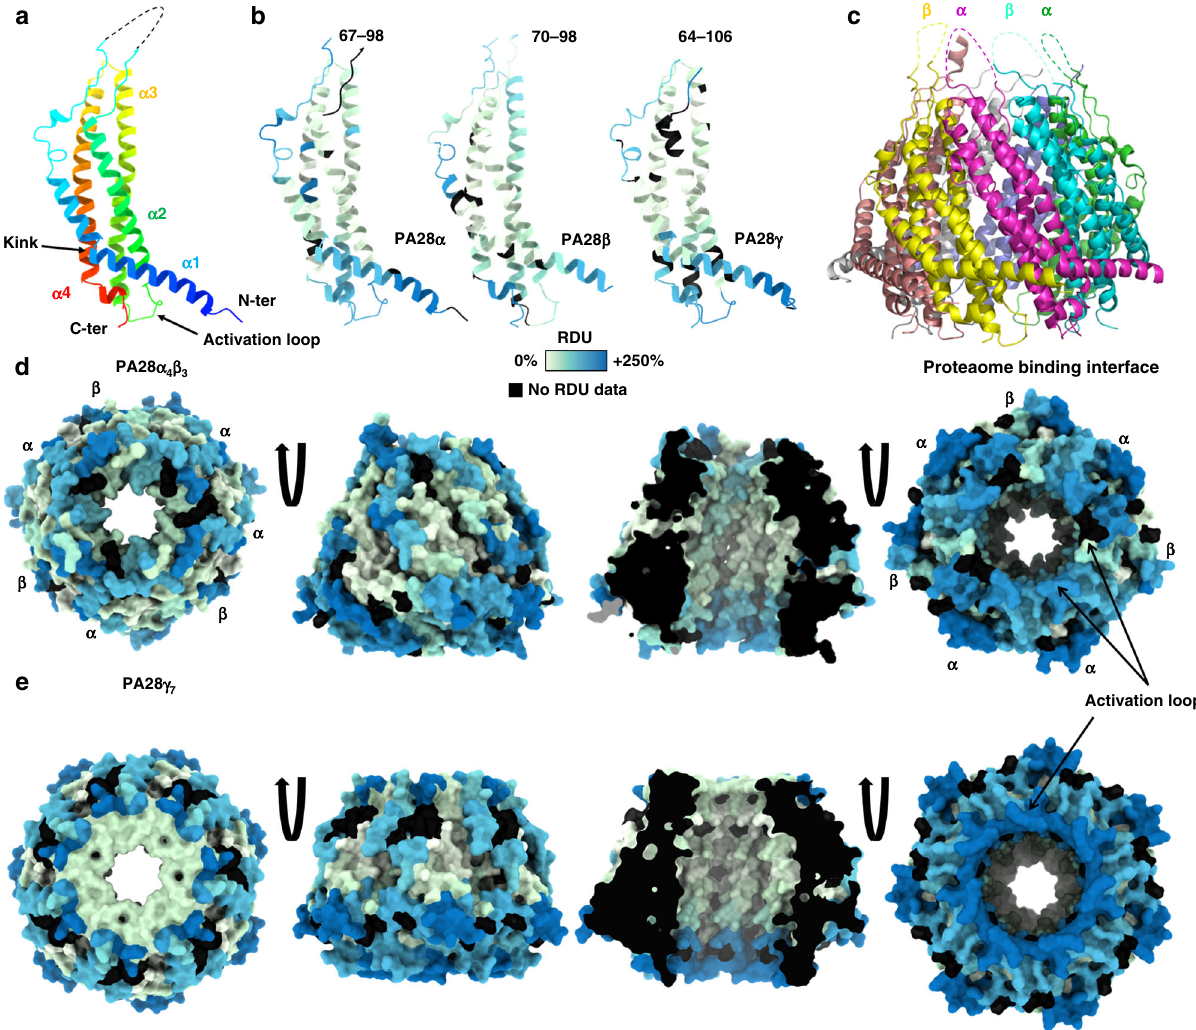
Fig. 5 PA28 regulators present fl exible loops on both ends of the channel. a , b Structure of monomeric PA28 α , β , or γ showing the 4-helix-bundle colored based on amino-acid numbering ( a ) or the sum of hydrogen-deuterium relative uptake accumulated over 30 min in PA28 γ or PA28 α 4 β 3 in solution ( b ). The residues corresponding to the missing apical loops (dashed lines) are indicated in b. c Structure of the heptameric complex PA28 α 4 β 3 (PDB: 5MX5 33 ). Only four apical loops out of seven are represented, for the sake of clarity. d , e Surface accessibility of the heptameric complexes PA28 α 4 β 3 ( d PDB: 5MX5) and PA28 γ 7 ( e homology model) viewed from the top (left), front and inside (middle), and bottom (right). Regions that were not detected are represented in black (described in Fig. 1b, c). RDU relative deuterium